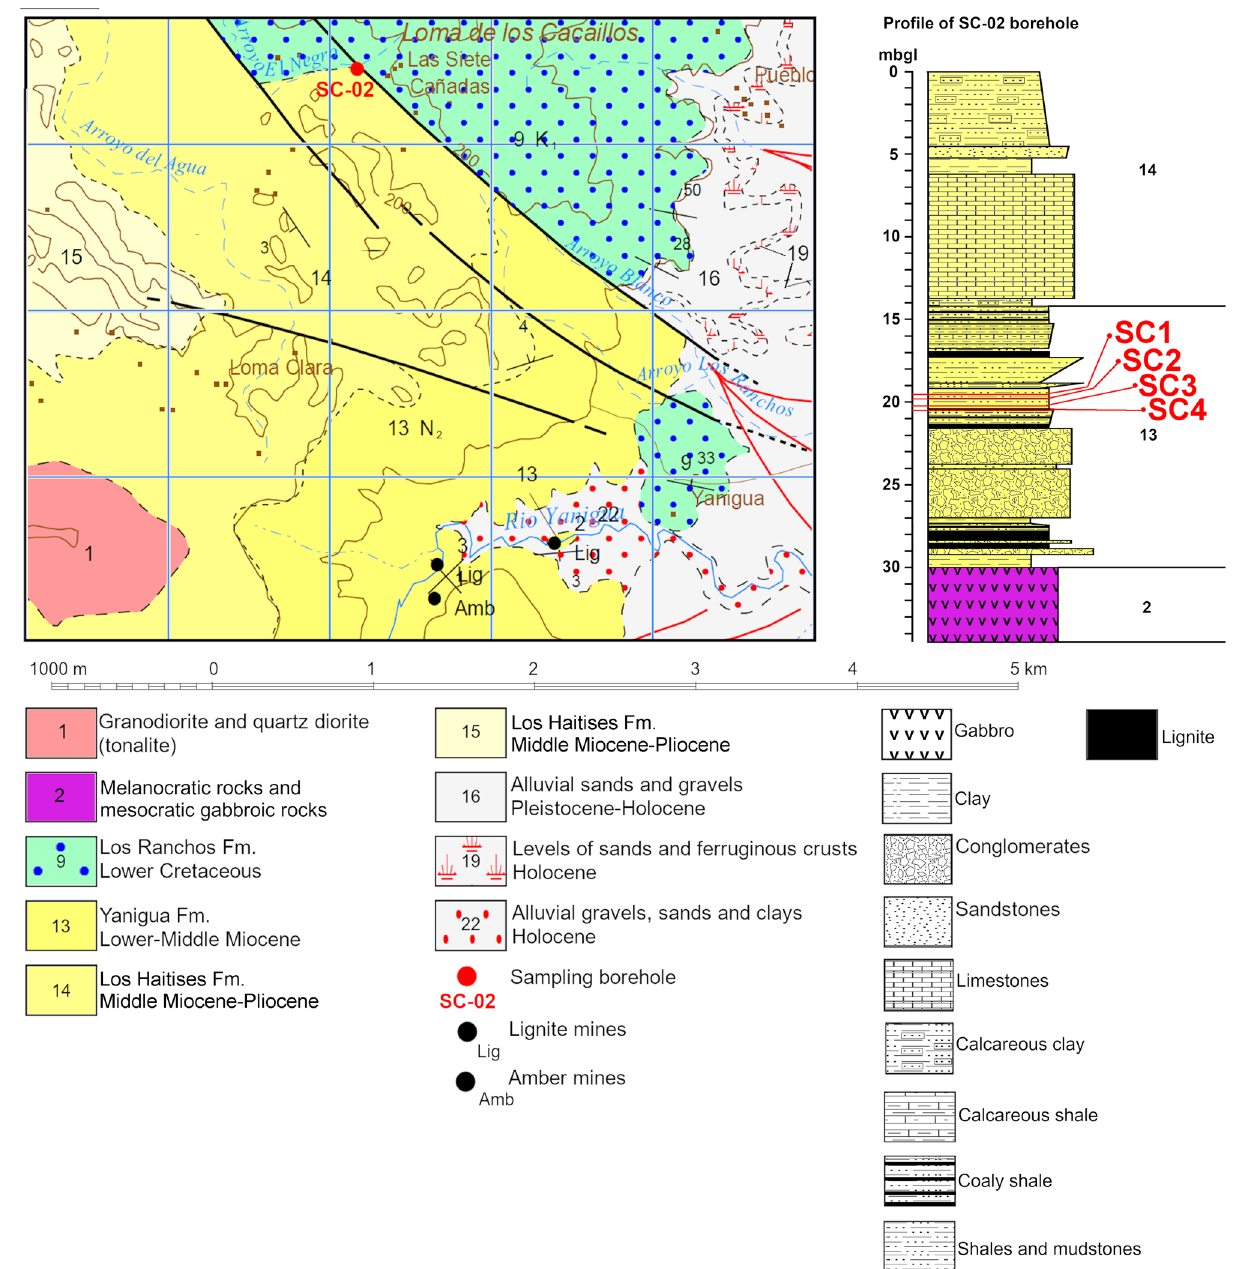
Figure 2. The geological map with the location and profile of sampling borehole SC-02 in the Siete Cañadas zone, based on the Geological Map of Dominican Republic at 1:50 000 scale—the El Valle sheet 6372-IV 43 and the literature herein 25,38 . mbgl—metres below ground level; 9—Volcanic and metamorphosed (low grade) volcaniclastic rocks, 13—Alternation of clays, shales, sandstones and marls with coal layers and marly limestones, locally conglomerates, 14—Marly limestones and reef limestones, 15—Reef limestones. This figure was drawn using CorelDRAW X5 and URL link is https:// www. corel draw.